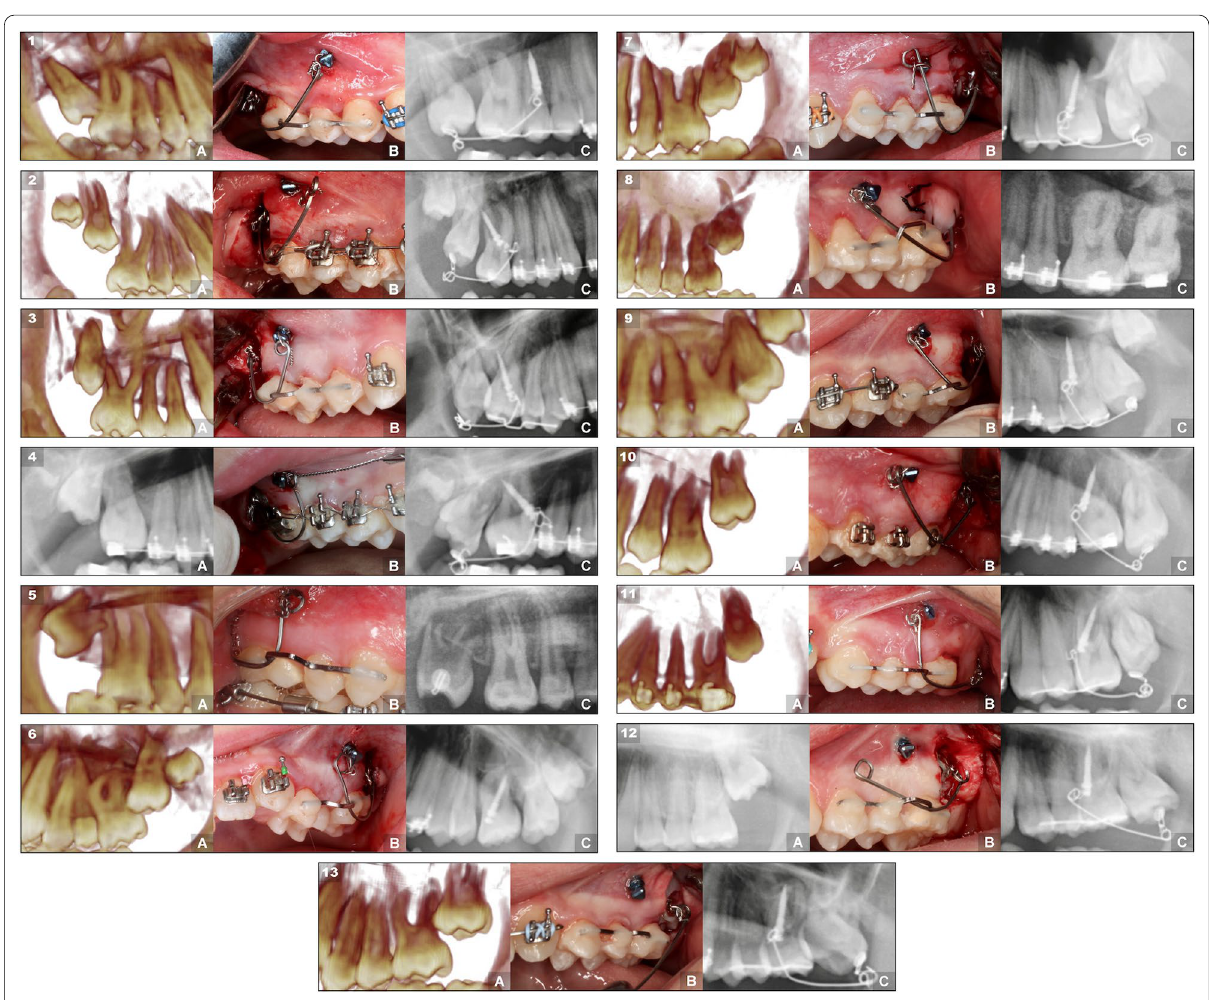
Fig. 4 Case series of maxillary M2s treated with the miniscrew‑supported pole technique. The 13 cases are organized according to their angulation, from mesial to distal, showing first the right ones and then the left ones. Each case is composed of three images that represent three moments during the treatment: a pretreatment radiograph showing the impacted or retained upper molar. b molar with the pole technique surgery carried out. c radiograph showing the final result with the molar in a correct position and